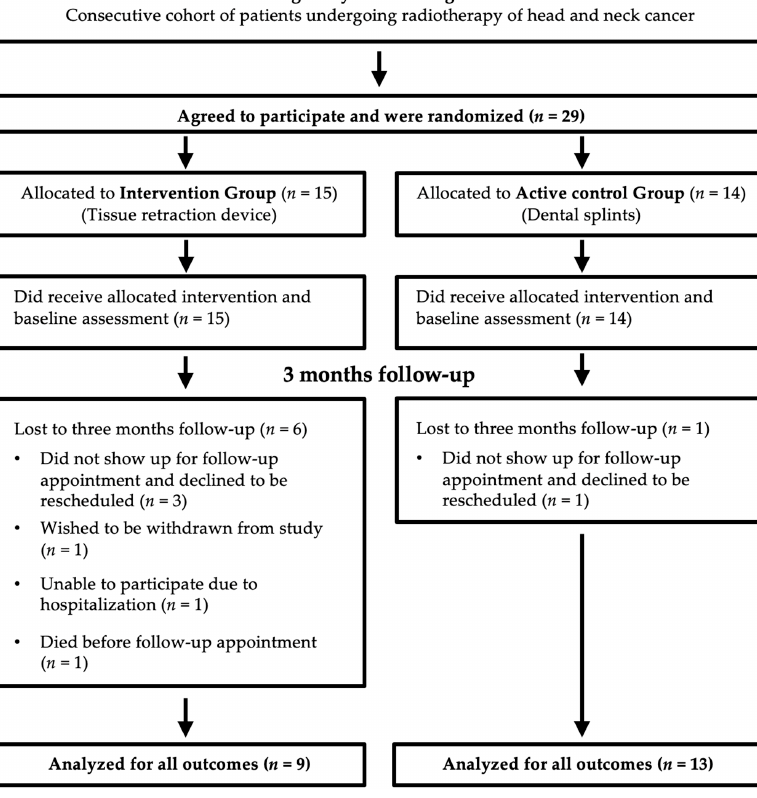
Figure 4. Flow diagram of study participation.